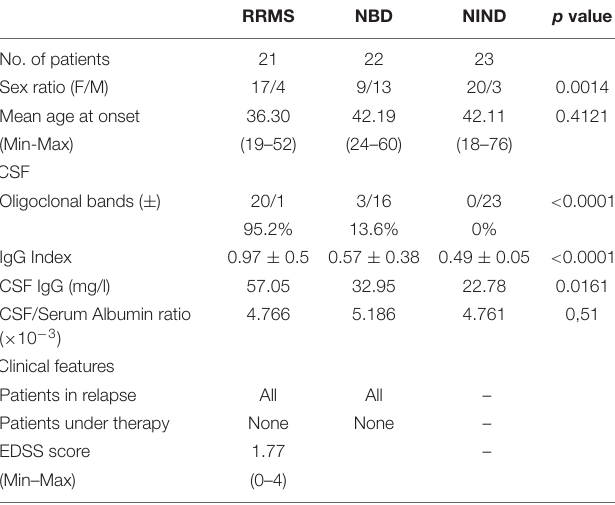
TABLE 1 | Demographic and clinical characteristics of